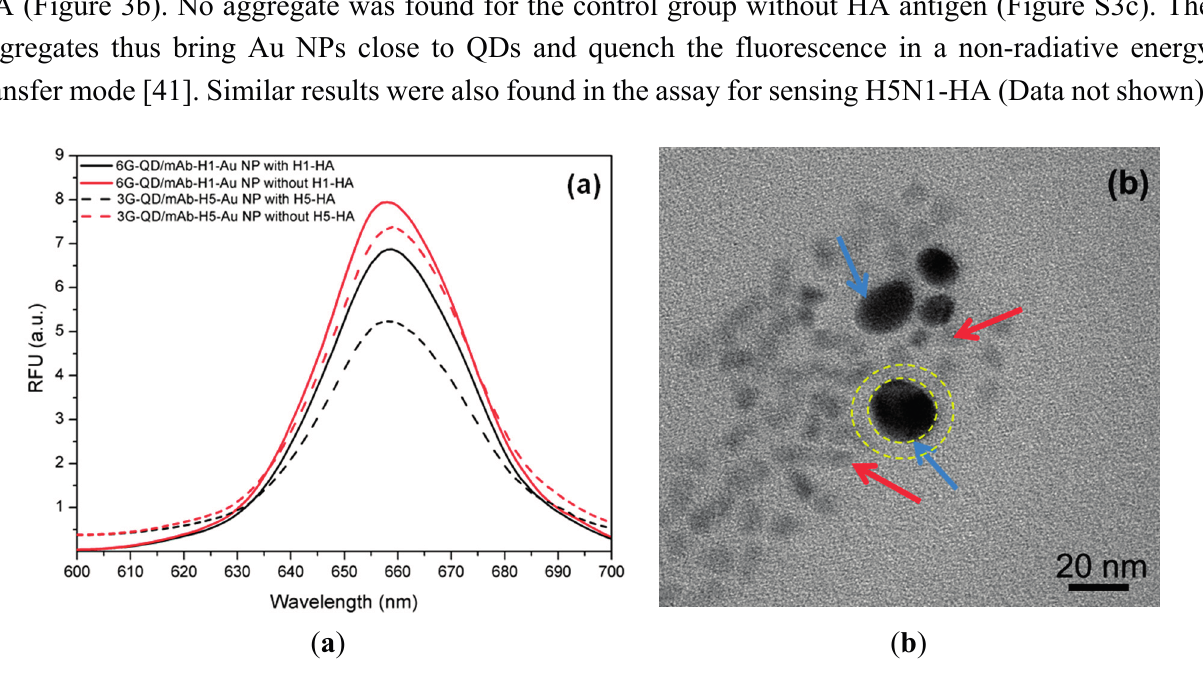
Figure 3. ( a ) Fluorescent spectra of 6G-QDs/mAb-H1-Au NPs mixture with and without antigen H1N1-HA; ( b ) TEM image of 6G-QDs/mAb-H1-Au NPs mixture after incubation with H1N1- HA. Blue arrow indicates Ab-Au NPs which has higher electron density, while red arrow indicates Gly-QDs which has a relative lower electron